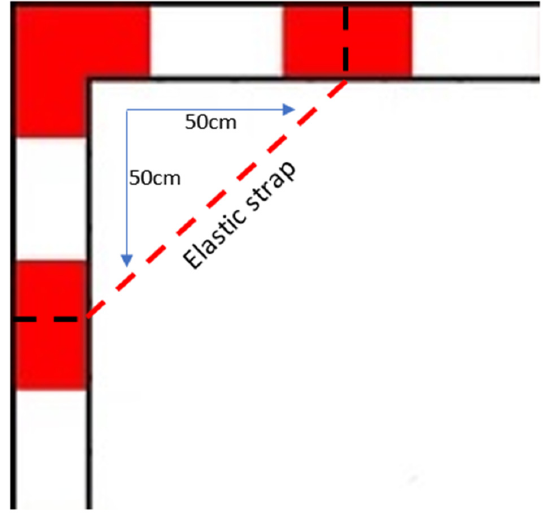
Figure 1. Illustration of target setting on the upper goal post.